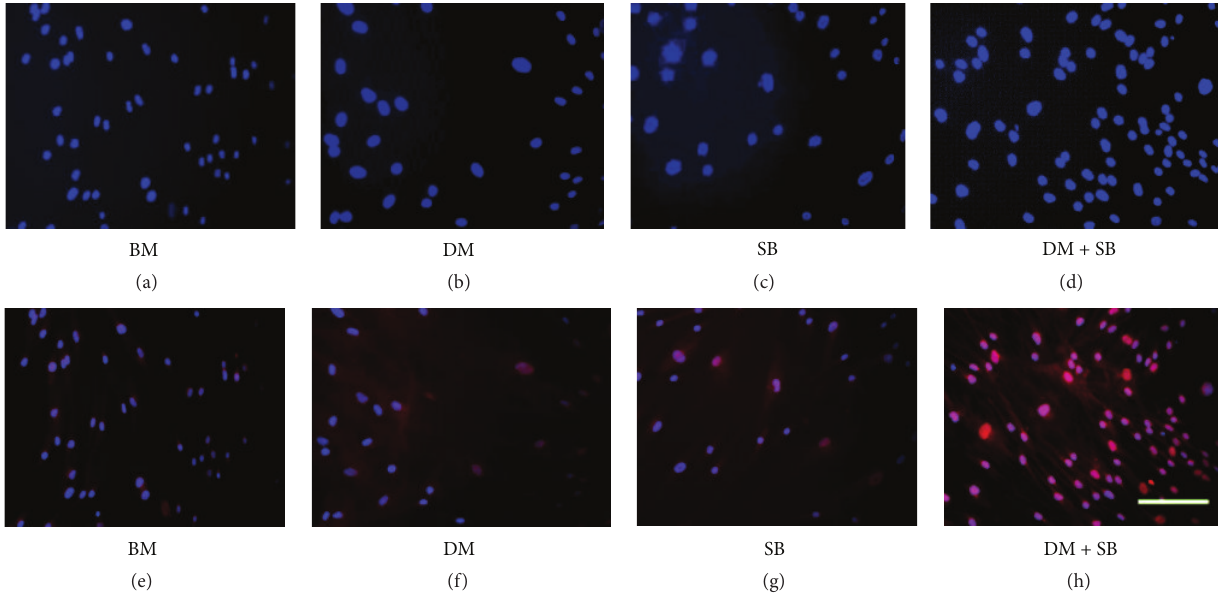
Figure 2: hADSCs express neuron-specific enolase upon dual inhibition of activin/nodal/TGF- 𝛽 and BMP signaling pathways. hADSCs were cultured in BM or BM containing either activin/nodal/TGF- 𝛽 pathway inhibitor SB or BMP pathway inhibitor DM or both for 14 days. Cells were stained with DAPI ((a)–(d)) or DAPI and anti-enolase antibody followed by Alexa Fluor 594 conjugated anti-rabbit secondary antibody ((e)–(h)). Images were captured under a fluorescent microscope. While addition of SB alone induced enolase expression in 14% of hADSCs, more than 85% of hADSCs expressed enolase upon addition of both SB and DM. Scale bar = 100 𝜇